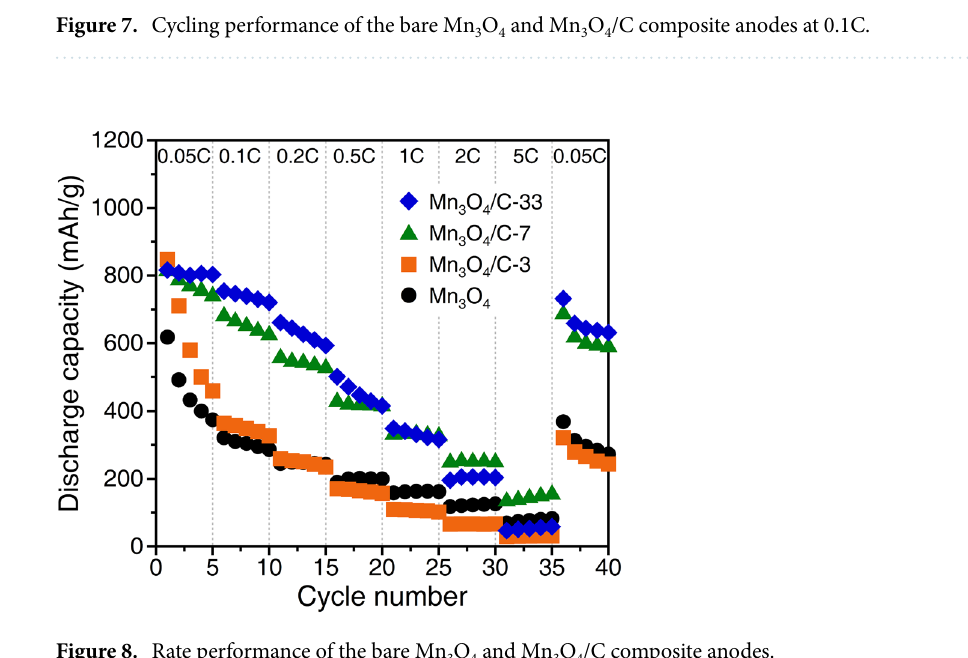
Figure 8. Rate performance of the bare Mn 3 O 4 and Mn 3 O 4 /C composite